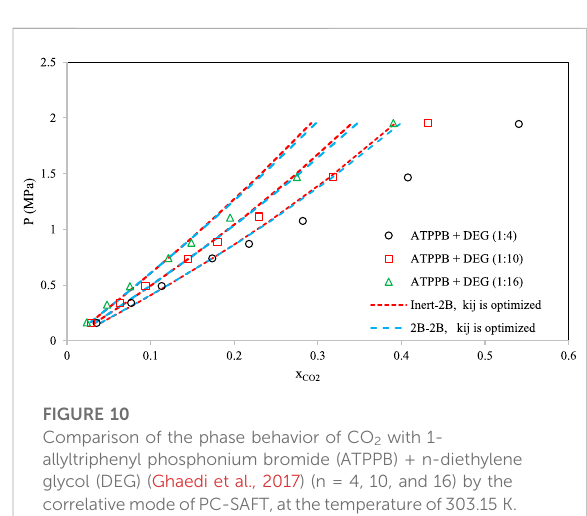
FIGURE 10 Comparison of the phase behavior of CO 2 with